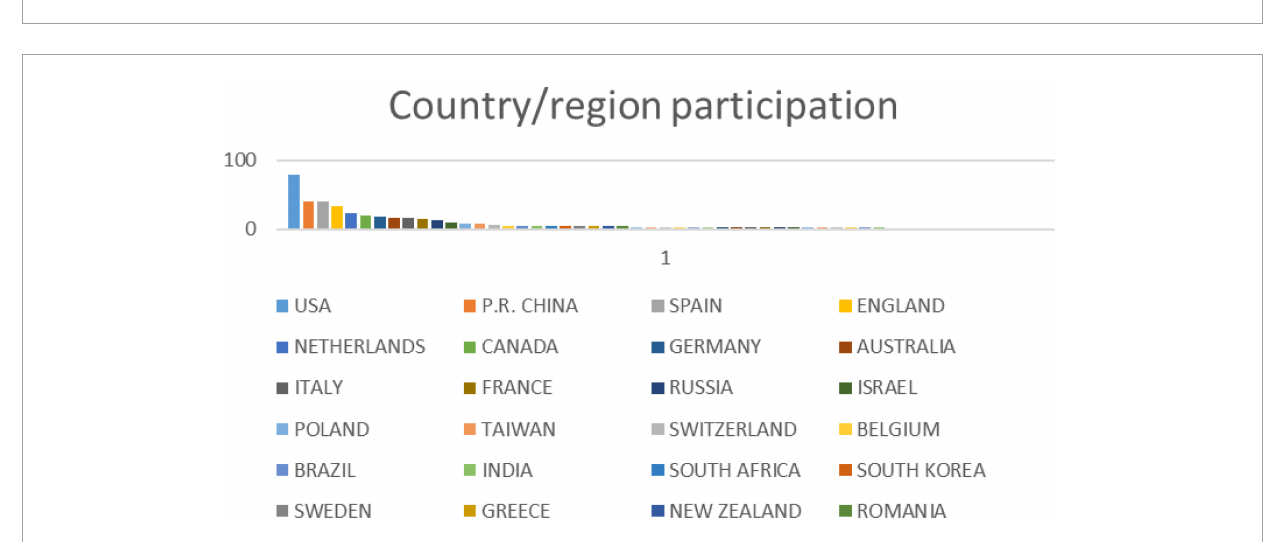
FIGURE2 Countries or regions that participated in research related to multimodal